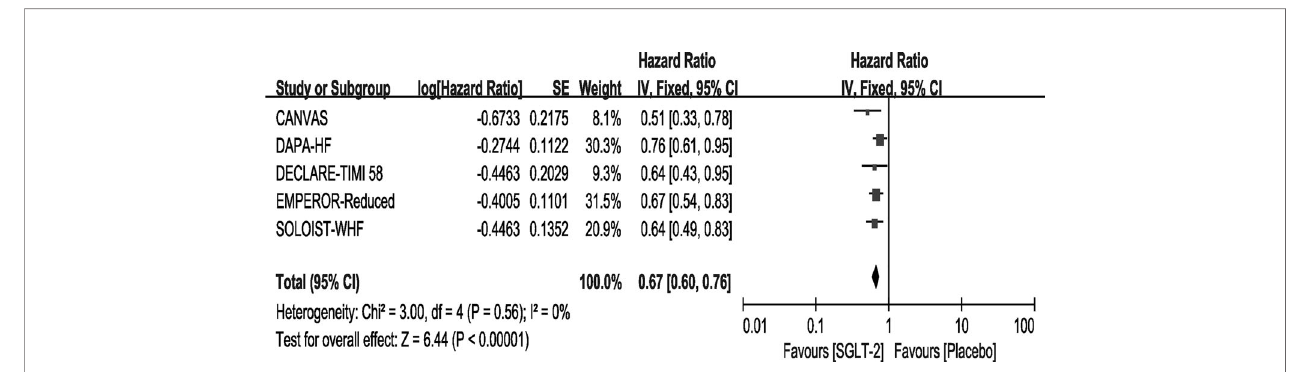
FIGURE 4 | Outcome of HHF in patients with T2DM and HF.